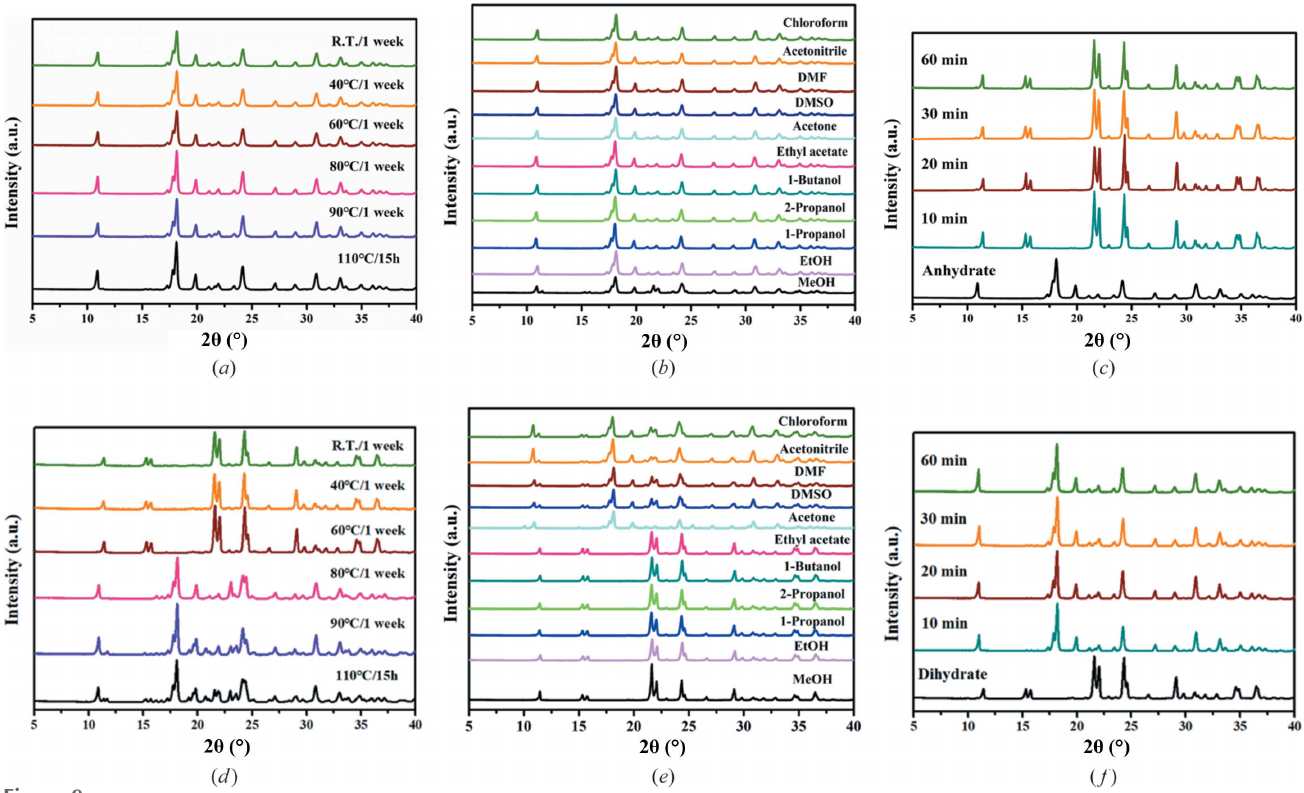
Figure 9 SST and slurry results for the ( a )–( c ) anhydrate and ( d )–( f ) dihydrate of PDA-OXA under different temperature and solvent